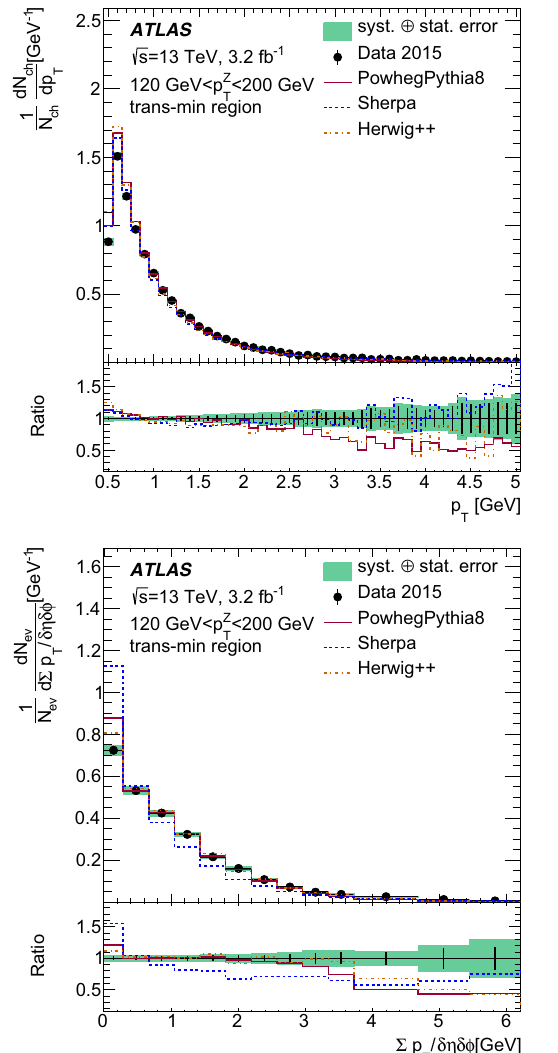
Fig. 5 Measured p T spectra (upper left), the charged-particle multi- plicity N ch (upper right), the scalar sum of the transverse momentum of those particles (cid:8) p T (lower left), and the mean transverse momen- tum, mean p T (lower right) in the trans-min region inclusively in T ⊥ for